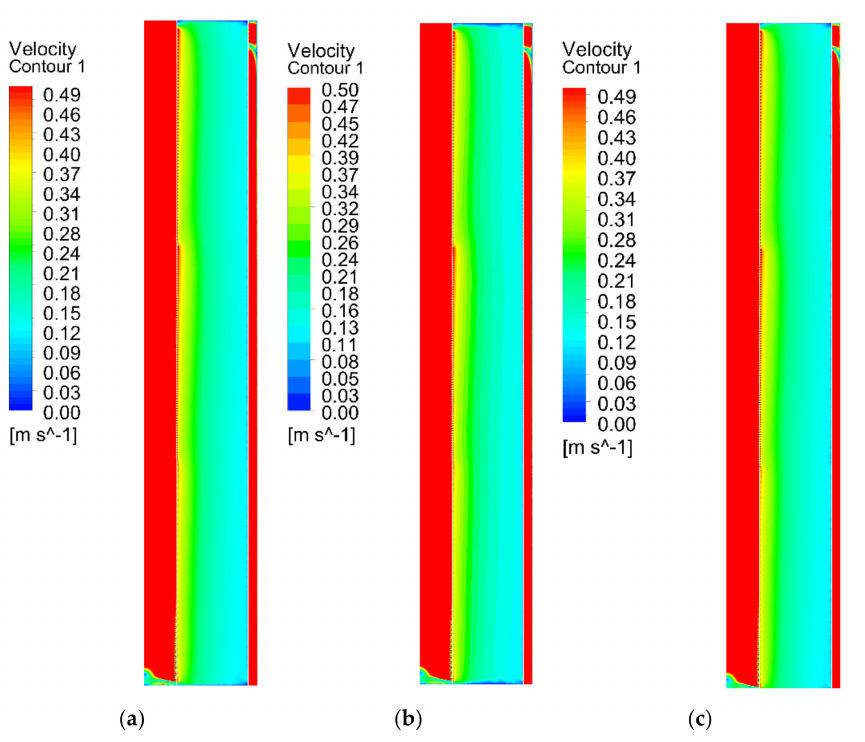
Figure 10. Velocity contour at the location of the annular channel; ( a ) Velocity contour for strategy 4; ( b ) Velocity contour for strategy 2; ( c ) Velocity contour for strategy 5.